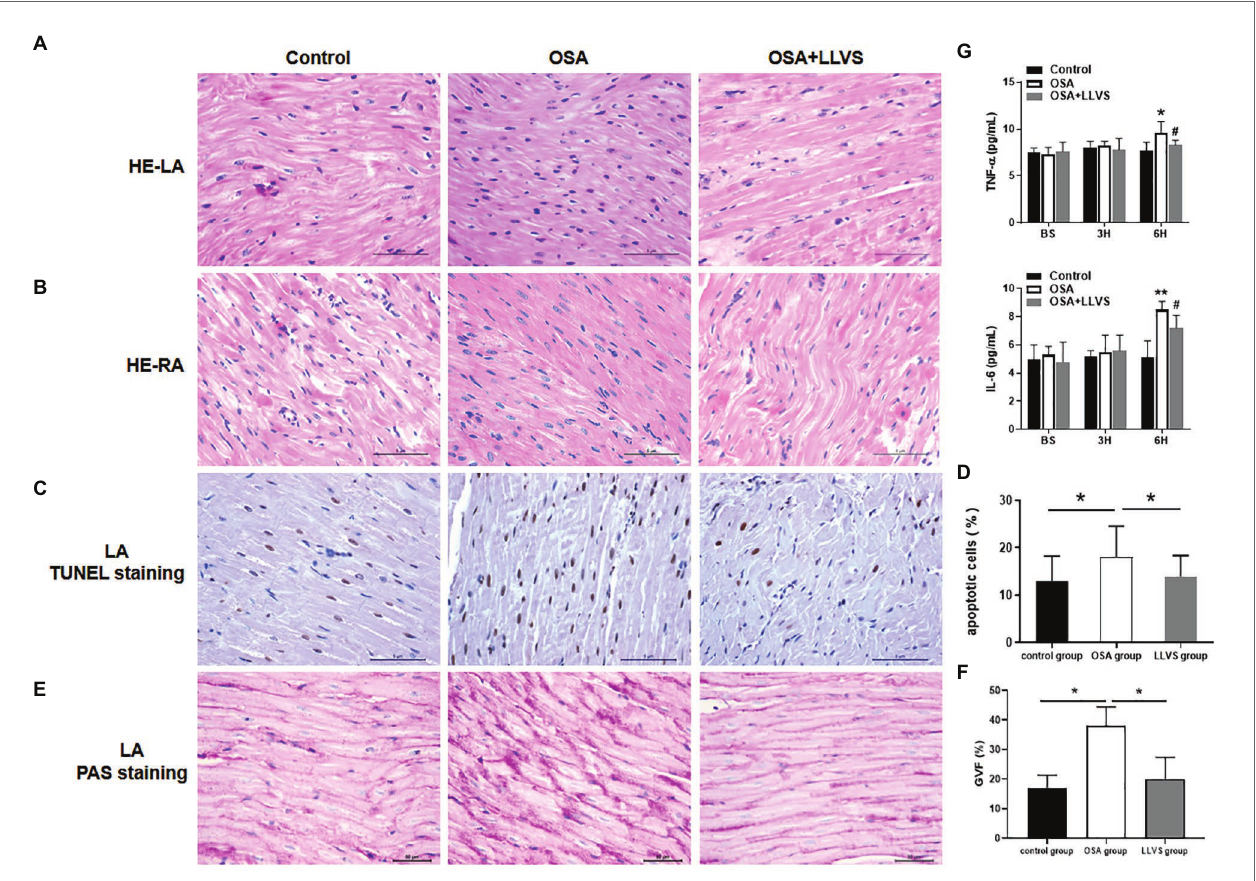
FIGURE 7 | Changes in cardiomyocytes among the three groups. HE staining showed that cardiomyocytes in the LA (A) and RA (B) were arranged tightly and orderly across the three groups. (C) Representative TUNEL staining on the LA across the three groups. (D) Quantitative analysis of TUNEL-positive cells in the LA of each group. (E) Representative PAS staining in the LA among the three groups. (F) Quantitative analysis of the glycogen volume fraction in the LA of each group. (G) The concentrations of TNF- α and IL-6 among the three groups at baseline, the 3rd hour, and the 6th hour. * p < 0.05, ** p < 0.01 vs. the control group; # p < 0.05 vs. the OSA+LLVS group; HE, hematoxylin and eosin; TUNEL, terminal deoxynucleotidyl transferase dUTP nick end labeling; PAS, periodic acid-Schiff; TNF- α , tumor necrosis factor alpha; IL-6, interleukin 6; H,